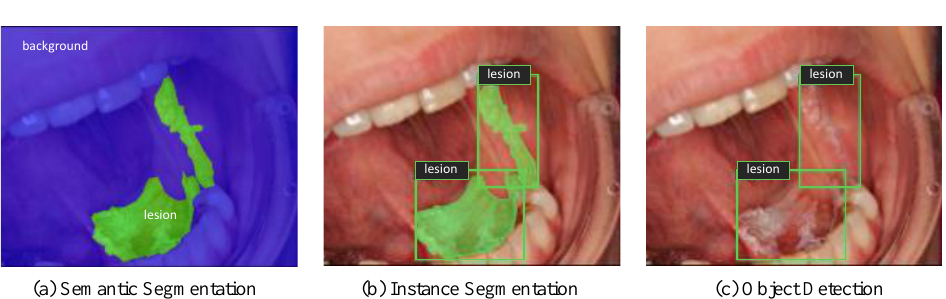
Figure 1. Different types of image recognition tasks showing ( a ) Semantic Segmentation, ( b ) Instance Segmentation, and ( c ) Object Detection.